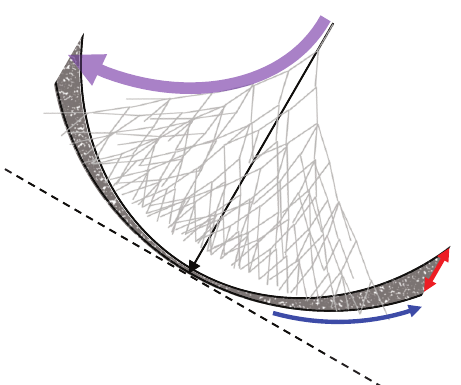
Figure 3: A schematic view of the development of an air shower around the surface. Dashed line and black arrow are shower plane and shower axis, respectively. Pur- ple, red and blue arrow indicates "lateral distribution", "thickness" and "curvature" of air showers, respec- tively.